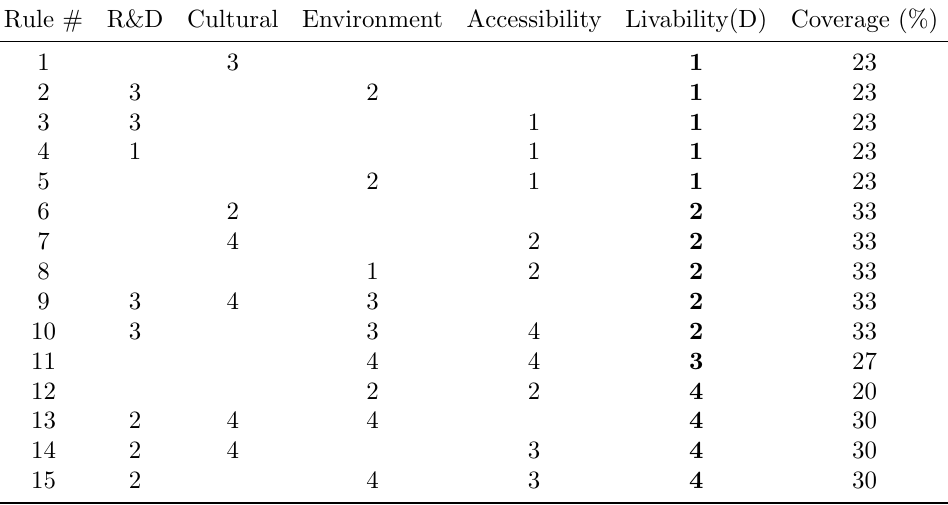
Table 4: Rough set rules explaining XXQ Livability by composite factors using 4